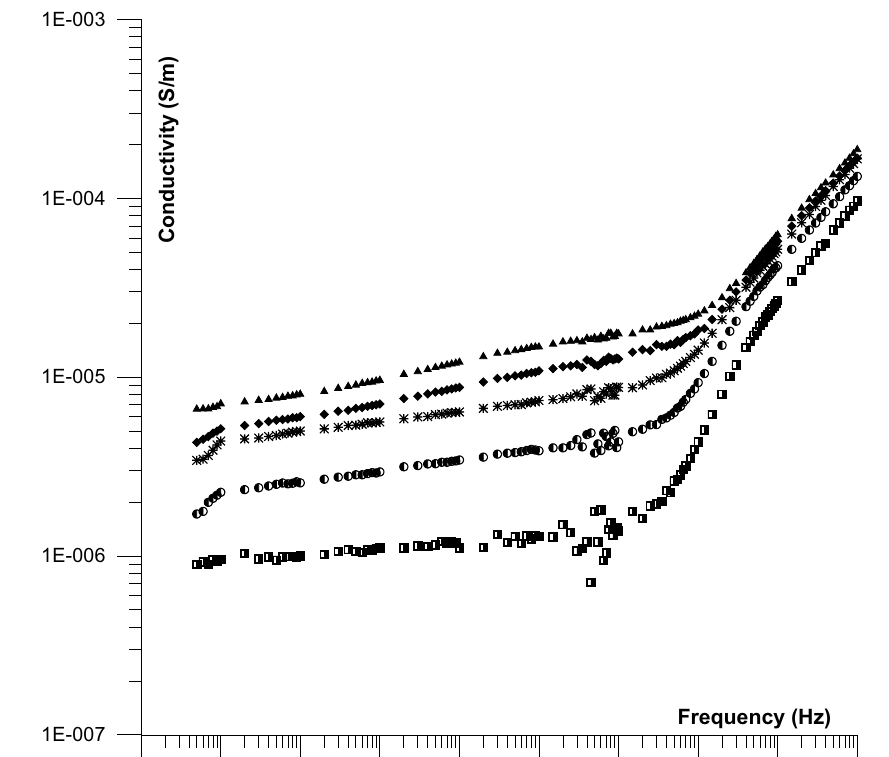
Fig. 2 âVariation of the conduc- tivity with frequency for Aswan iron ore deposits, for samples 1 ( ) , 2 ( ) , 3 ( ) , 4 ( ) and 5 ( ) ,